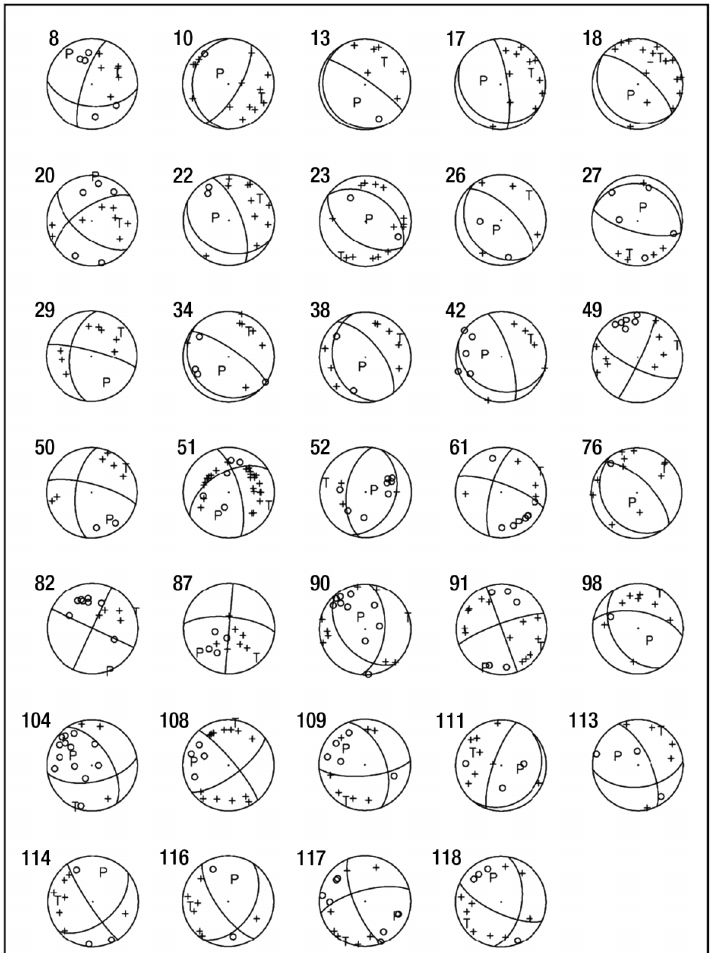
Fig. 6. Focal mechanisms computed with first motion polarities for 34 selected events. Event number corre- sponds to that in table